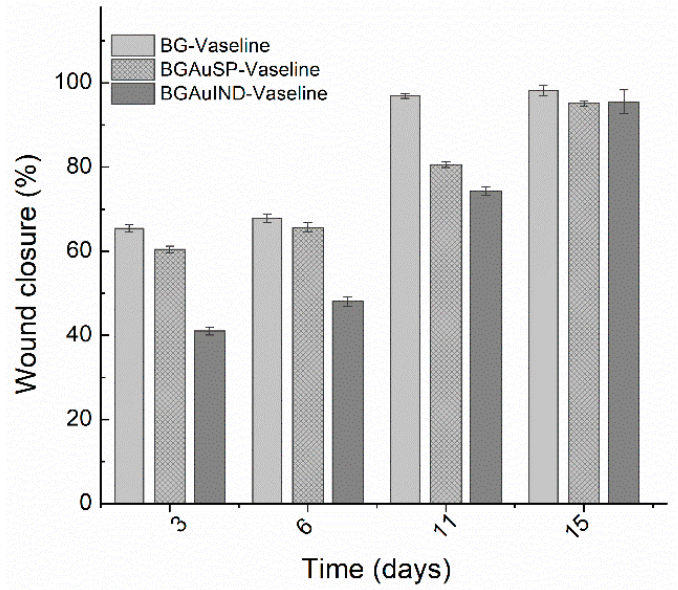
Figure 8. Percent of wound closure for the defect treated with BG-Vaseline, BGAuSP-Vaseline and BG-AuIND-Vaseline ointments. p < 0.05.